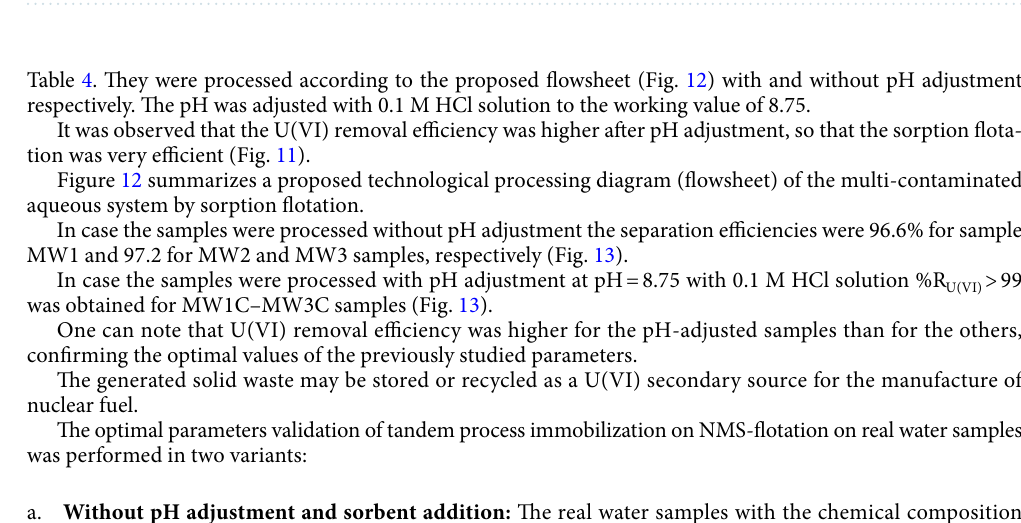
Table 2. The thermal analysis of sublates obtained after the separation by sorption/precipitate flotation of U(VI) from Cr (VI), Cu (II), and Mo